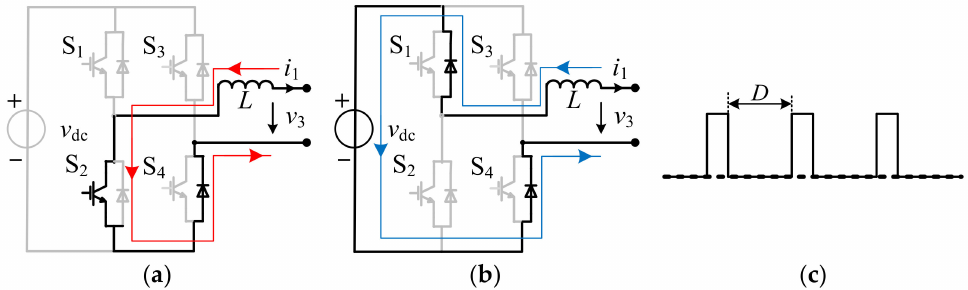
Figure 3. CCC state analysis: ( a ) current path when S 2 is on; ( b ) current path when S 2 is off; and ( c ) output